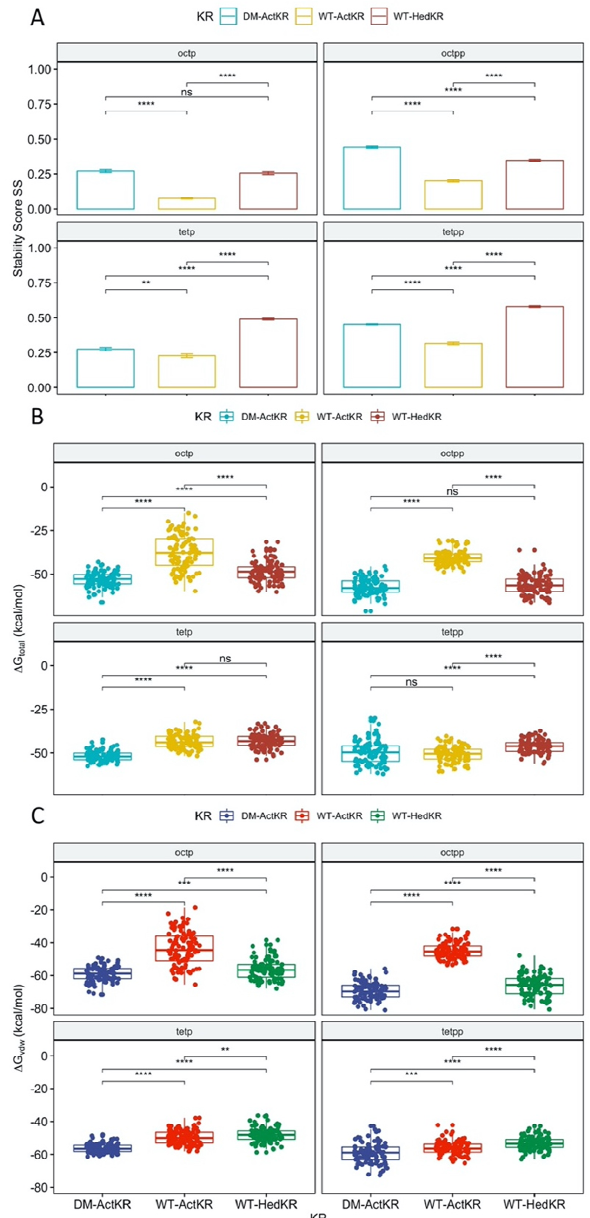
Figure 5. Stability score 𝑆𝑆 analysis and MMPBSA comparison of DM- Act KR, WT- Act KR and WT- Hed KR bound with tetraketides and octaketides. ( A ) For each ligand, the average stability score 𝑆𝑆 of DM- Act KR is significantly increased compared with WT- Act KR and is closer to that of WT- Hed KR. ( B ) The total binding free energy ∆ G total results. The total binding free energy of DM- Act KR is shifted towards that of WT- Hed KR for octaketides, but not tetraketides. ( C ) Non-electrostatic binding free energy ∆ G vdw shows similar pattern as ( B ). Significance levels: ns, p > 0.05; *, p <= 0.05; **, p <= 0.01; ***, p <= 0.001; ****, p <= 0.0001.